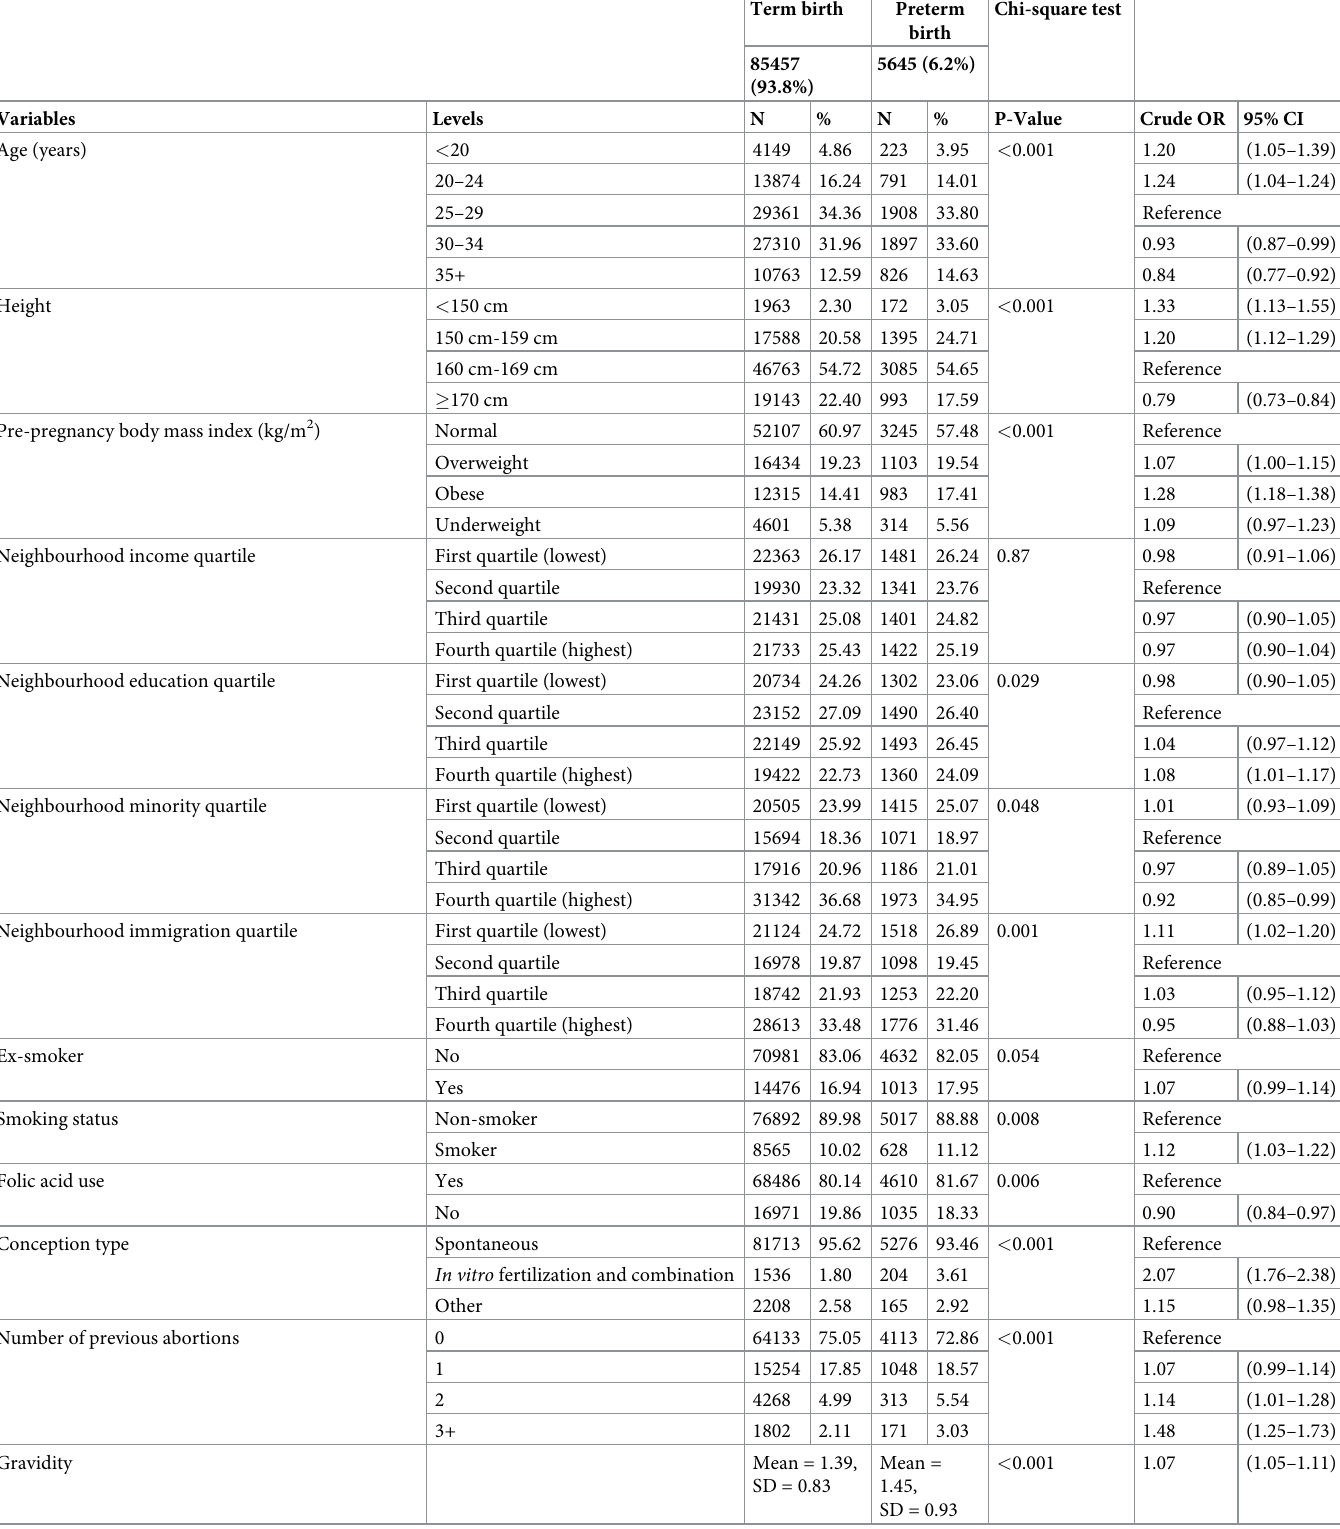
Table 2. Univariate analyses of associations between each predictor and preterm birth during the first trimester in nulliparous